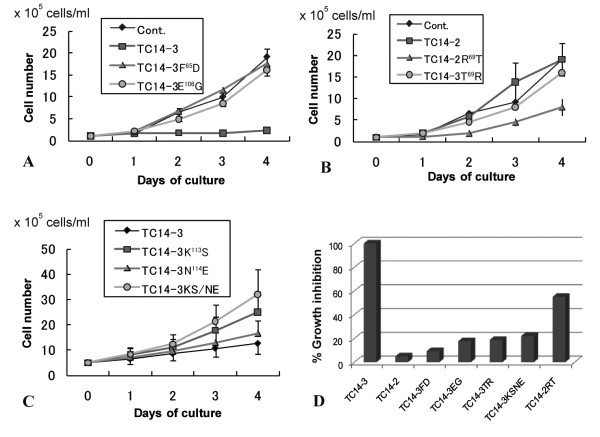
Quantitative data of cell growth inhibition of wild-type and mutant TC14s. Each histogram shows a mean ± standard deviation. (A)Effects of wild-type TC14-3, TC14-3F65D, and TC14-3E106G on cell growth. (B)Effects of wild-type TC14-2, TC14-2R69T, and TC14-3T69R on cell growth. (C)Effects of TC14-3K113S, TC14-3N114E, and TC14-3K113S.N114E on cell growth. (D)Relative cell growth inhibition activities of aberrant TC14s as compared with 100% activity of wild-type TC14-3.